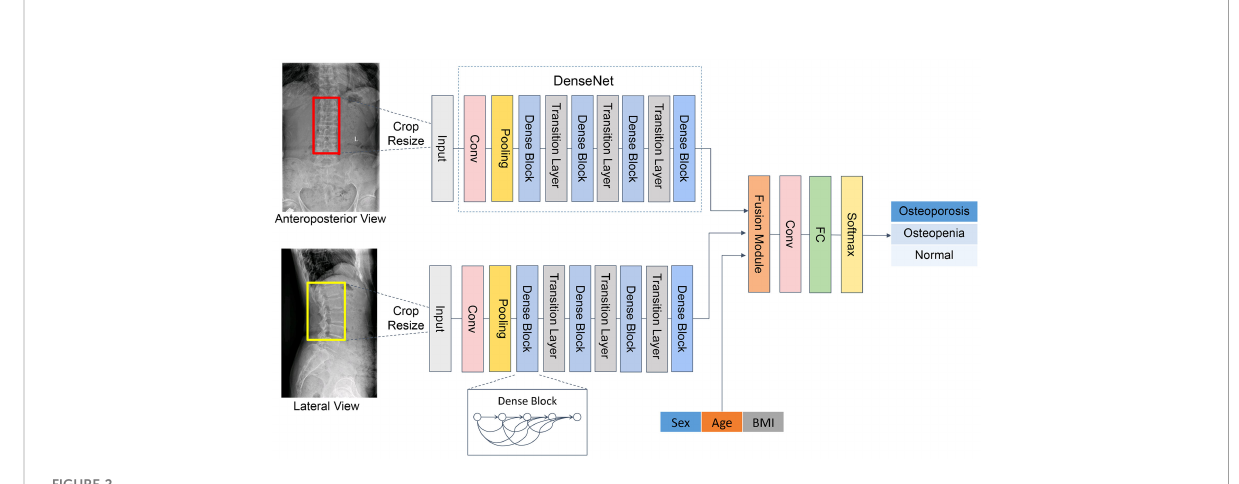
FIGURE 2 Overview of our proposed